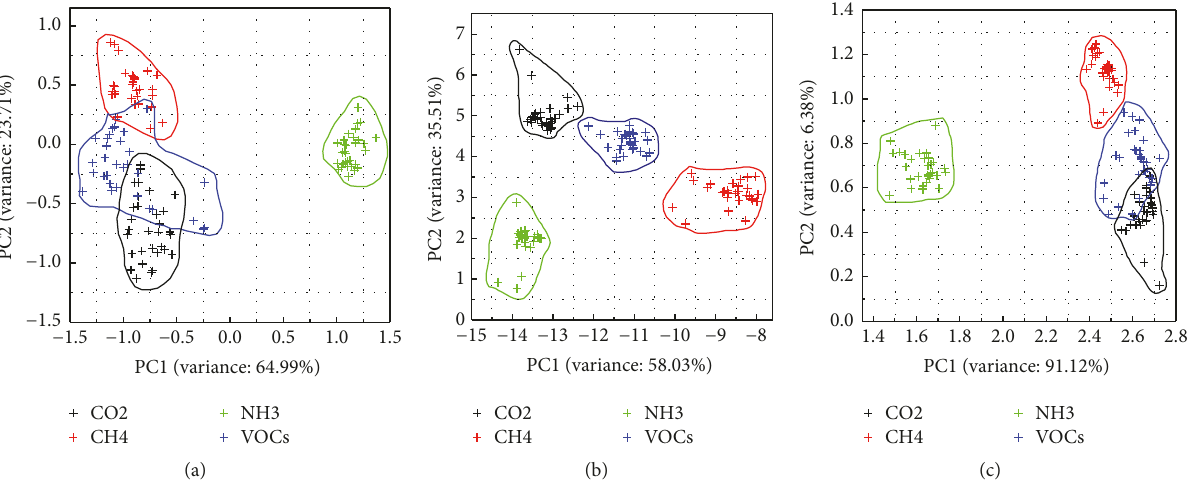
Figure 4: Classification results of PCA, LDA, and PCA + LDA method after the feature extraction corresponding to (a), (b), and (c), respectively. The horizontal axis and the vertical axis stand for the dimensionally reduced classification in the two-dimensional distribution